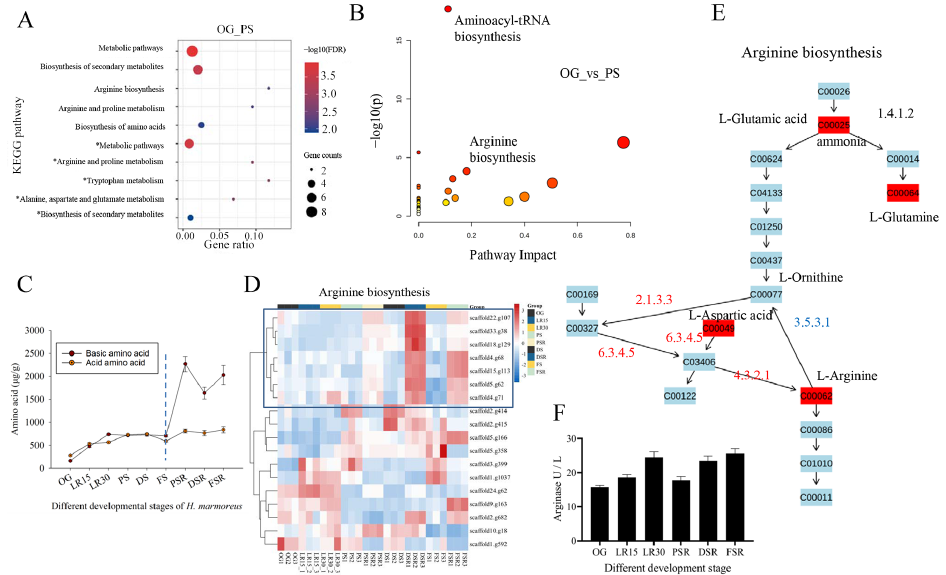
Figure 3. Transcriptome analysis of arginine biosynthesis in H. marmoreus. ( A ) KEGG enrichment analysis of the associated differentially expressed genes (DEGs) in OG vs. PS. * represents downregulated DEGs. ( B ) Correlation pathway analysis of the significantly different AAs (SDAs) in OG vs. PS (Impact > 1). ( C ) Analysis of the content of AAs in H. marmoreus at different developmental stages. ( D ) Heatmap analysis of gene expression in arginine biosynthesis. ( E ) KEGG pathway view (ko00350) of arginine biosynthesis. Red indicates upregulation in OG vs. PS. Blue suggests upregulation in OG vs. PS. ( F ) Determination of arginase enzyme activity in H. marmoreus at different developmental stages. The absolute quantitative transcriptome was used to obtain SRS expression